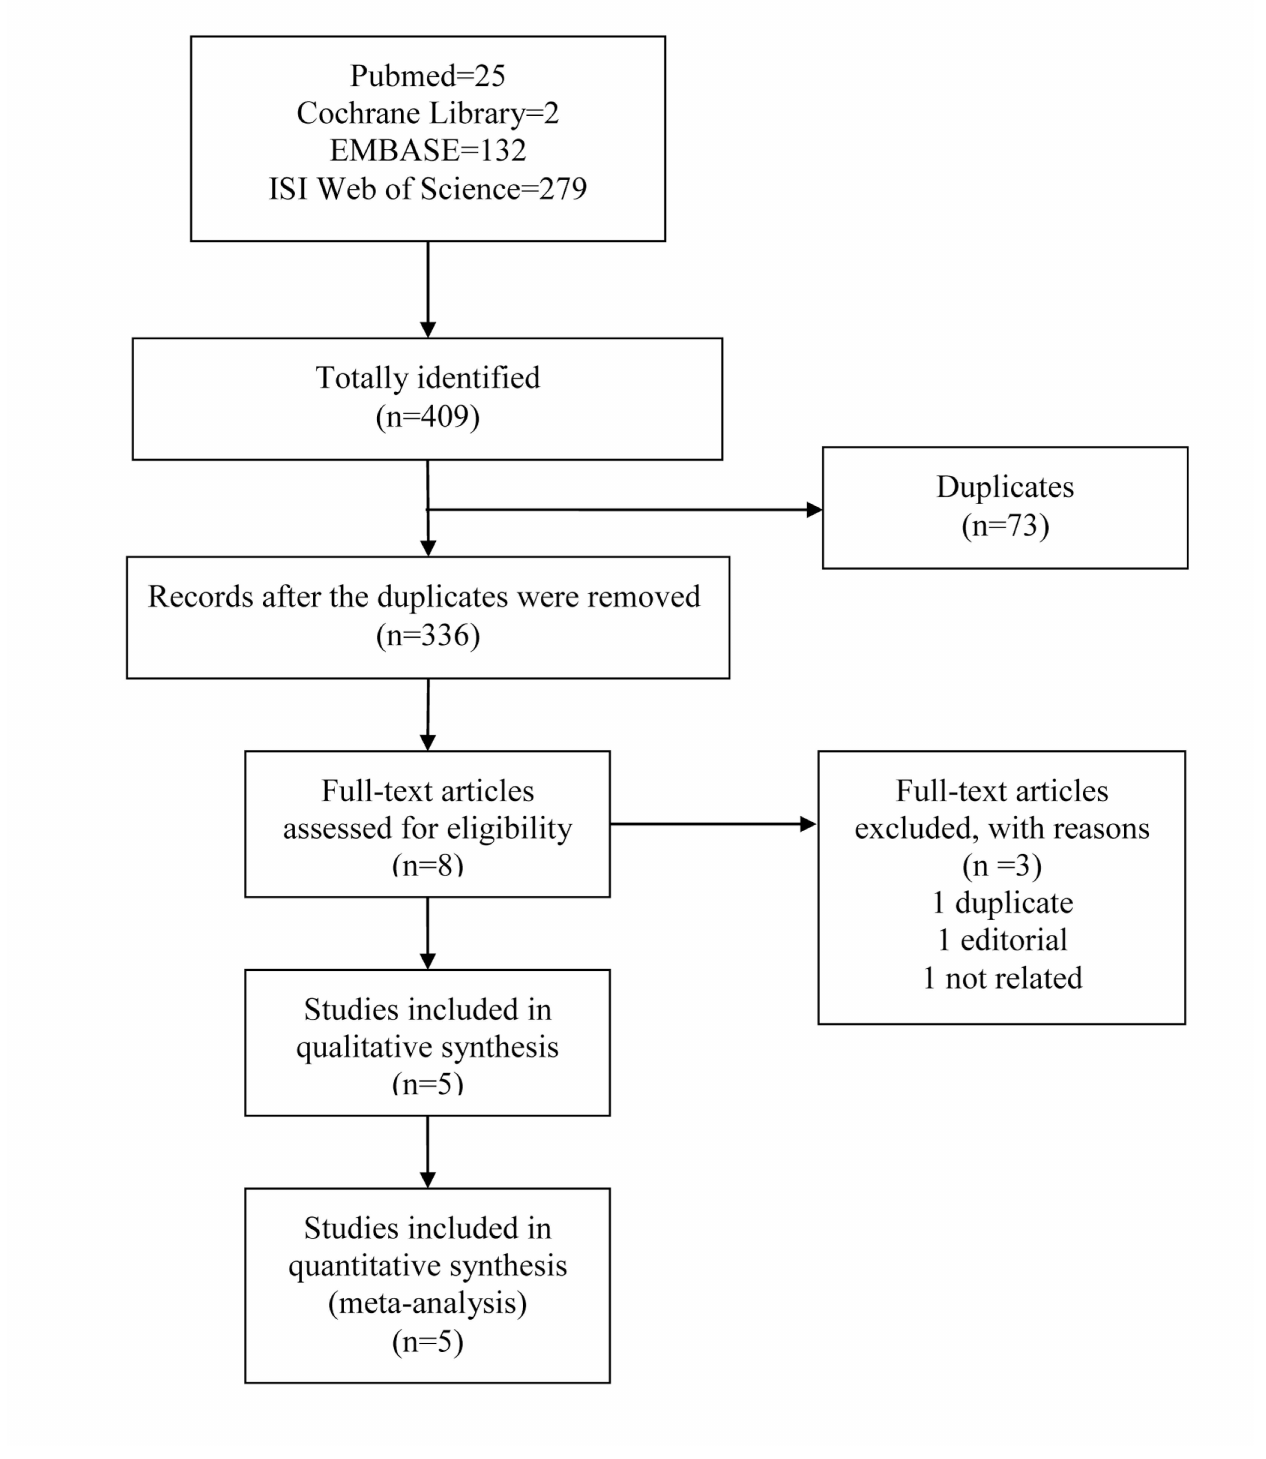
Fig 1. Flowchart of literature selection according to PRISMA guideline.